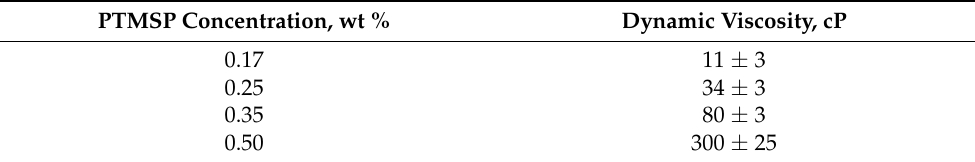
Table 2. Dynamic viscosity of the polymer